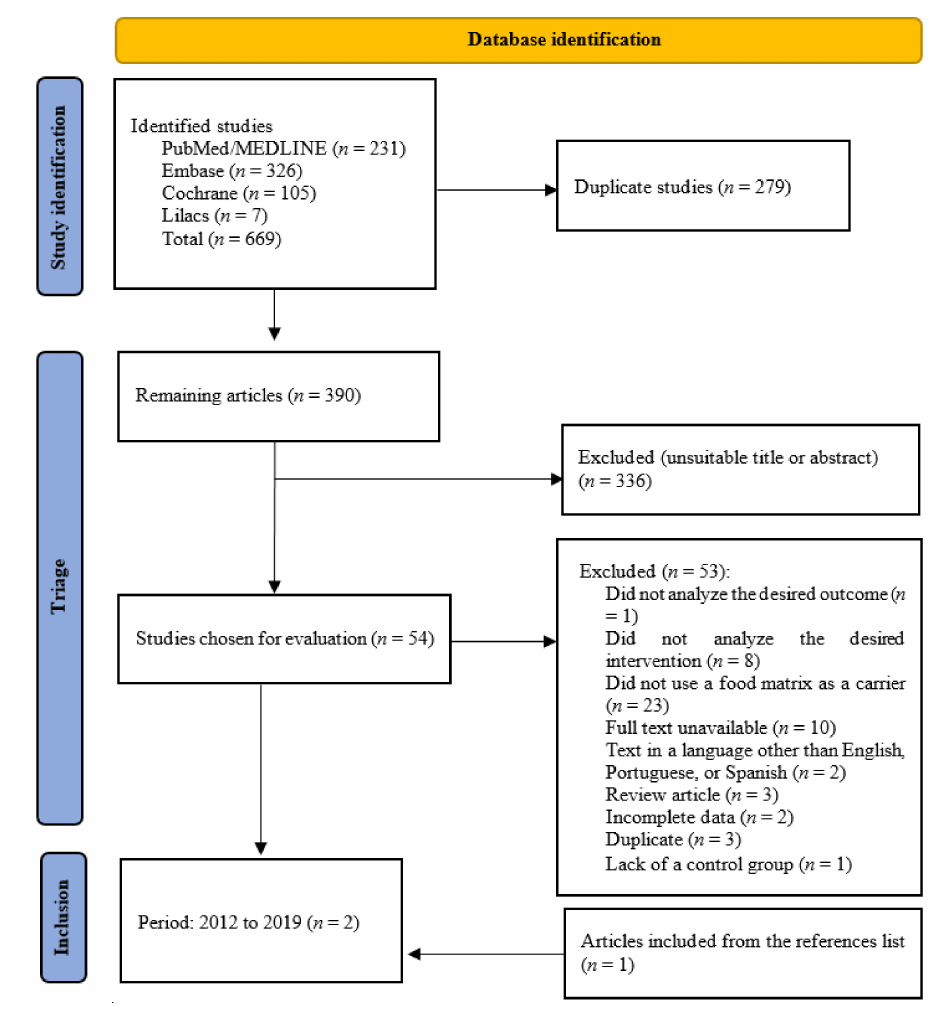
Figure 1. Flowchart of studies’